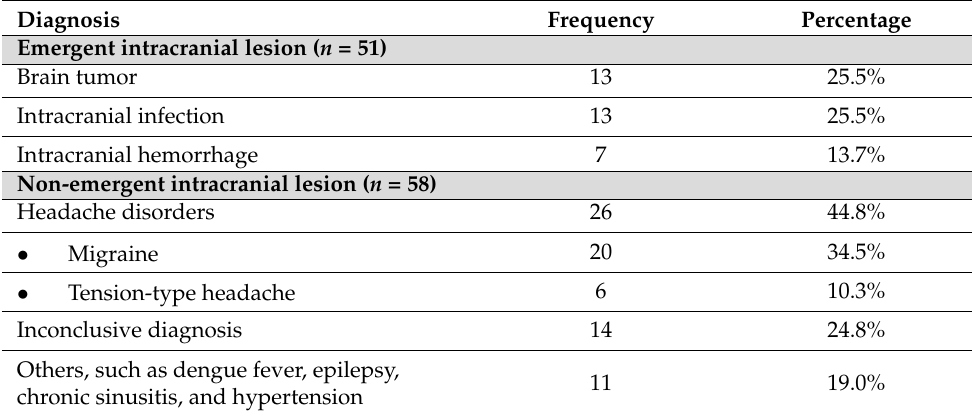
Table 2. The final diagnosis of the pediatric patients with non-traumatic